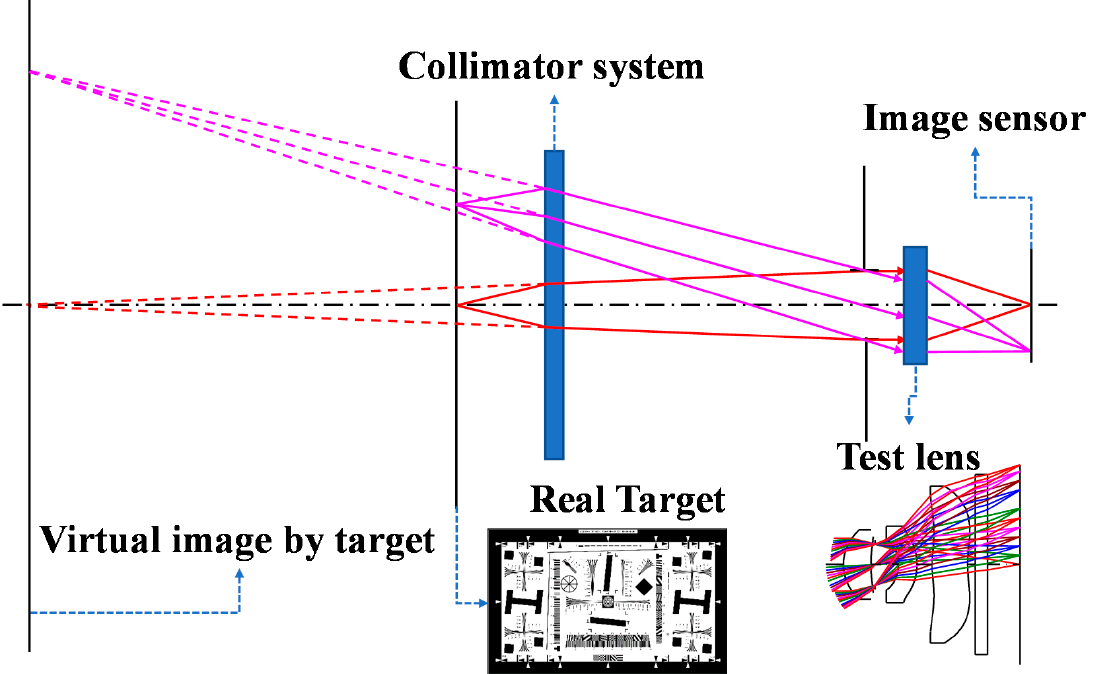
Figure 1. Layout of inspection instrument of mobile phone camera optics.